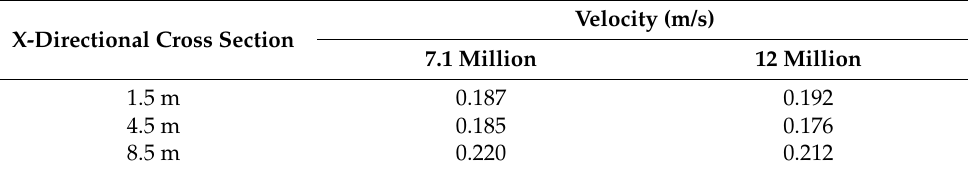
Table 4. The verification of grid independence.